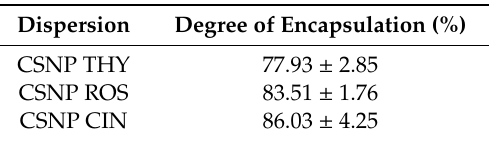
Table 2. The encapsulation e ffi ciency of thyme extract, rosemary extract and cinnamon extract in chitosan nanoparticles.